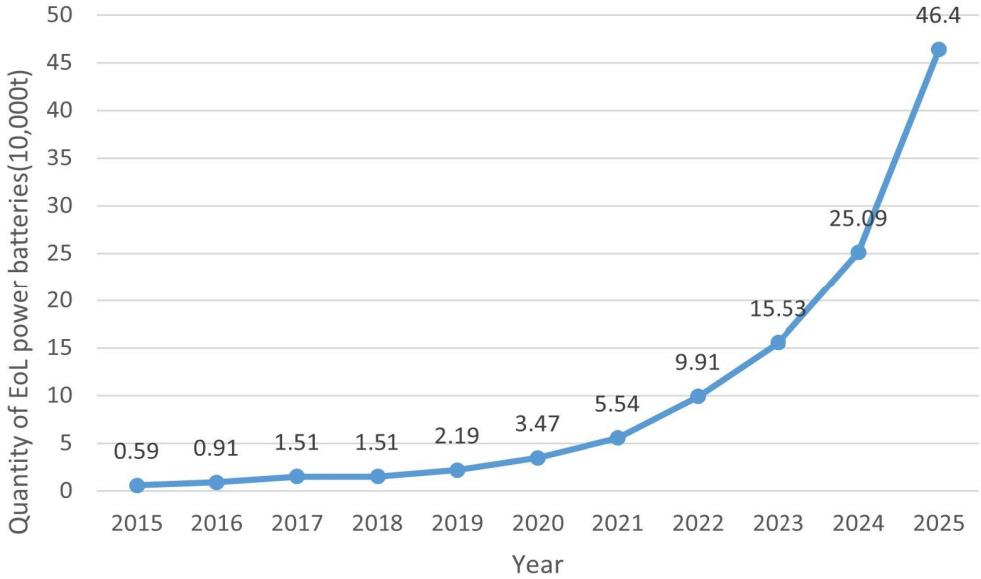
Figure 2. Forecast of the number of EoL power batteries in China by 2050